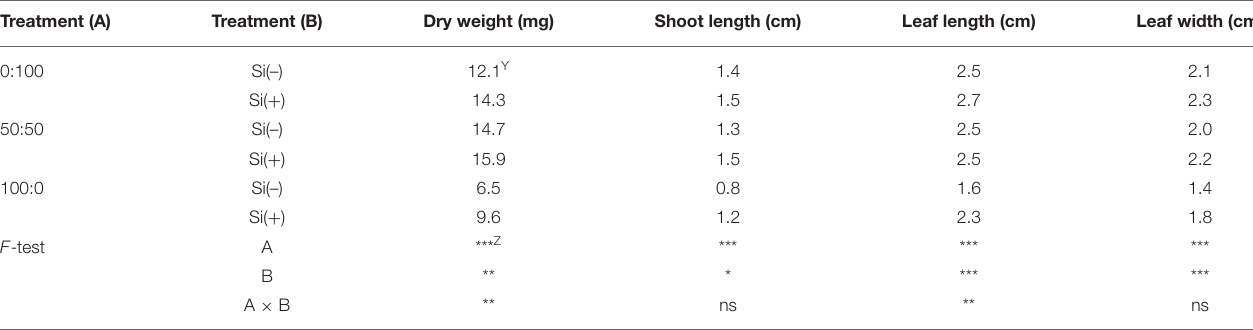
TABLE 2 | Dry weight, shoot length, leaf length and width as affected by three NH + 4 :NO − 3 ratios and Si application. Treatment (A)